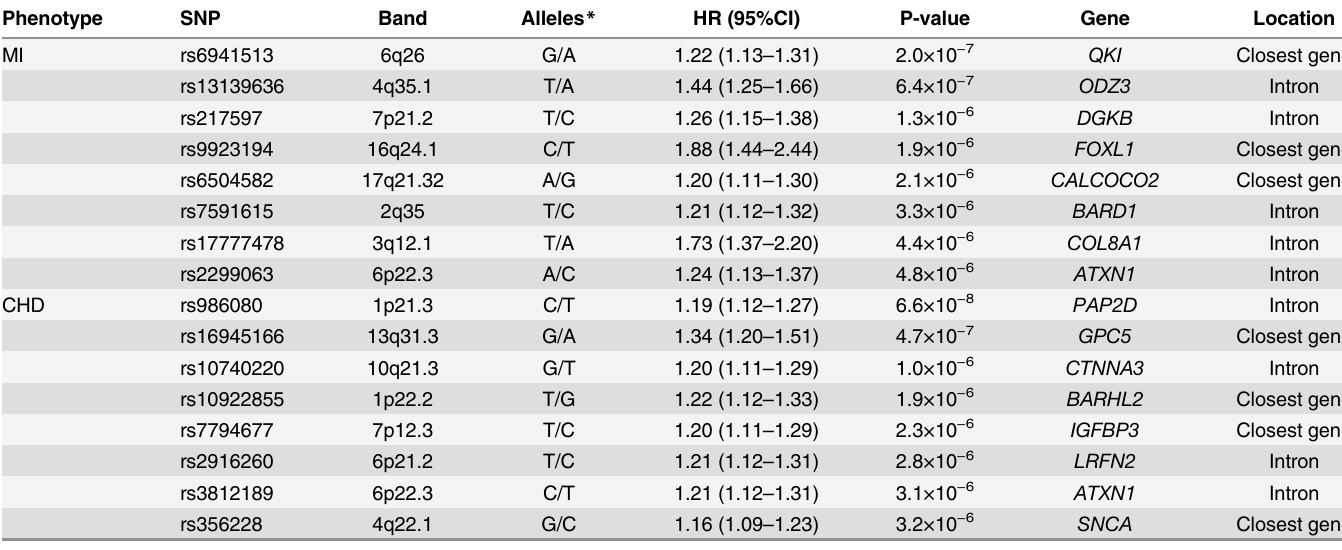
Table 2. Description and association of SNPs of the top loci associated with incident MI and CHD in Stage I.